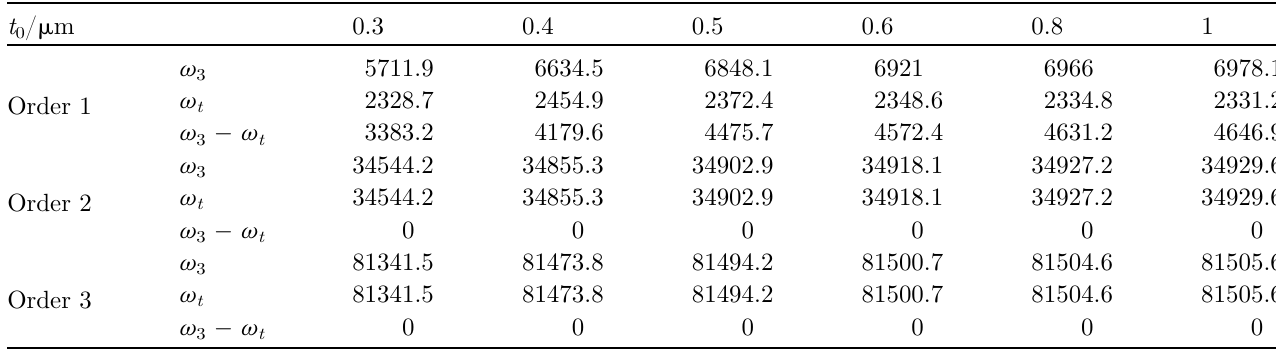
with and without friction force (rad/s). 0